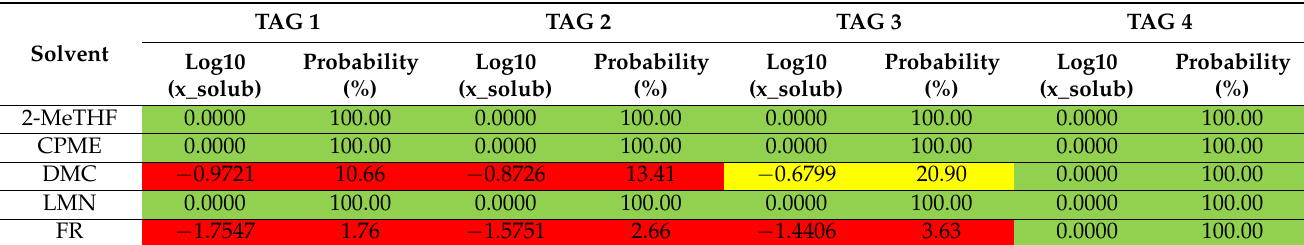
Table 1. COSMO-RS relative solubility (log10(x_solub)) and probability of solubility of triacylglycerides (TAGs) from monkfish liver oil using four different green solvents and Folch reagent (FR) as a reference solvent.